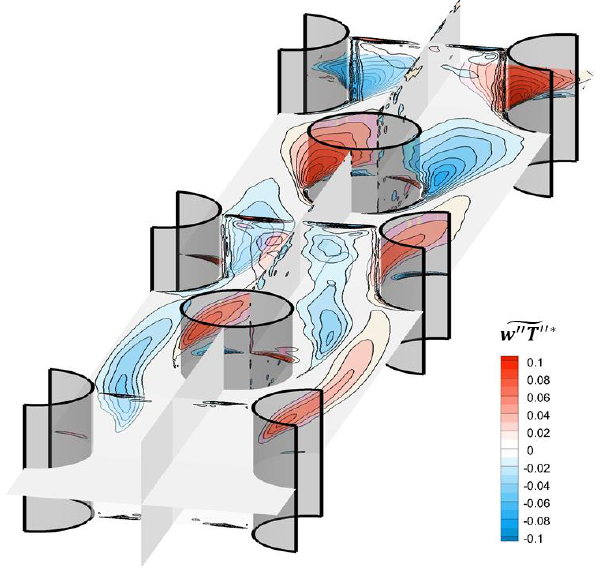
Figure 20. Resolved − (cid:94) w (cid:48)(cid:48) T (cid:48)(cid:48) ∗ in two midplanes (T w /T c = 4.0).